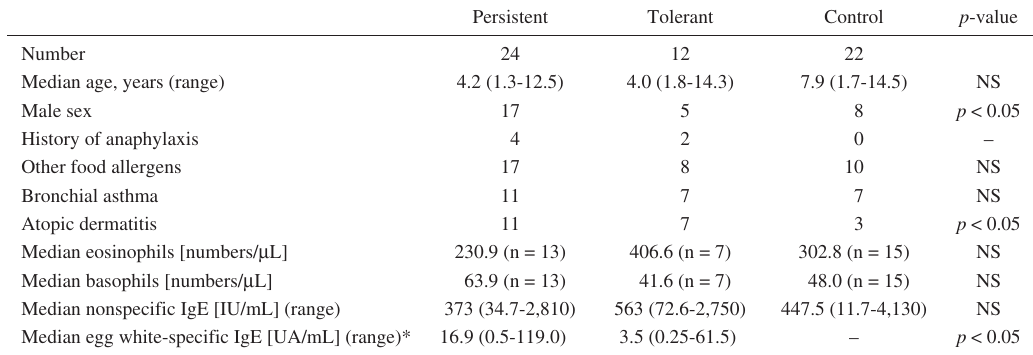
Table 1. Patient characteristics by study